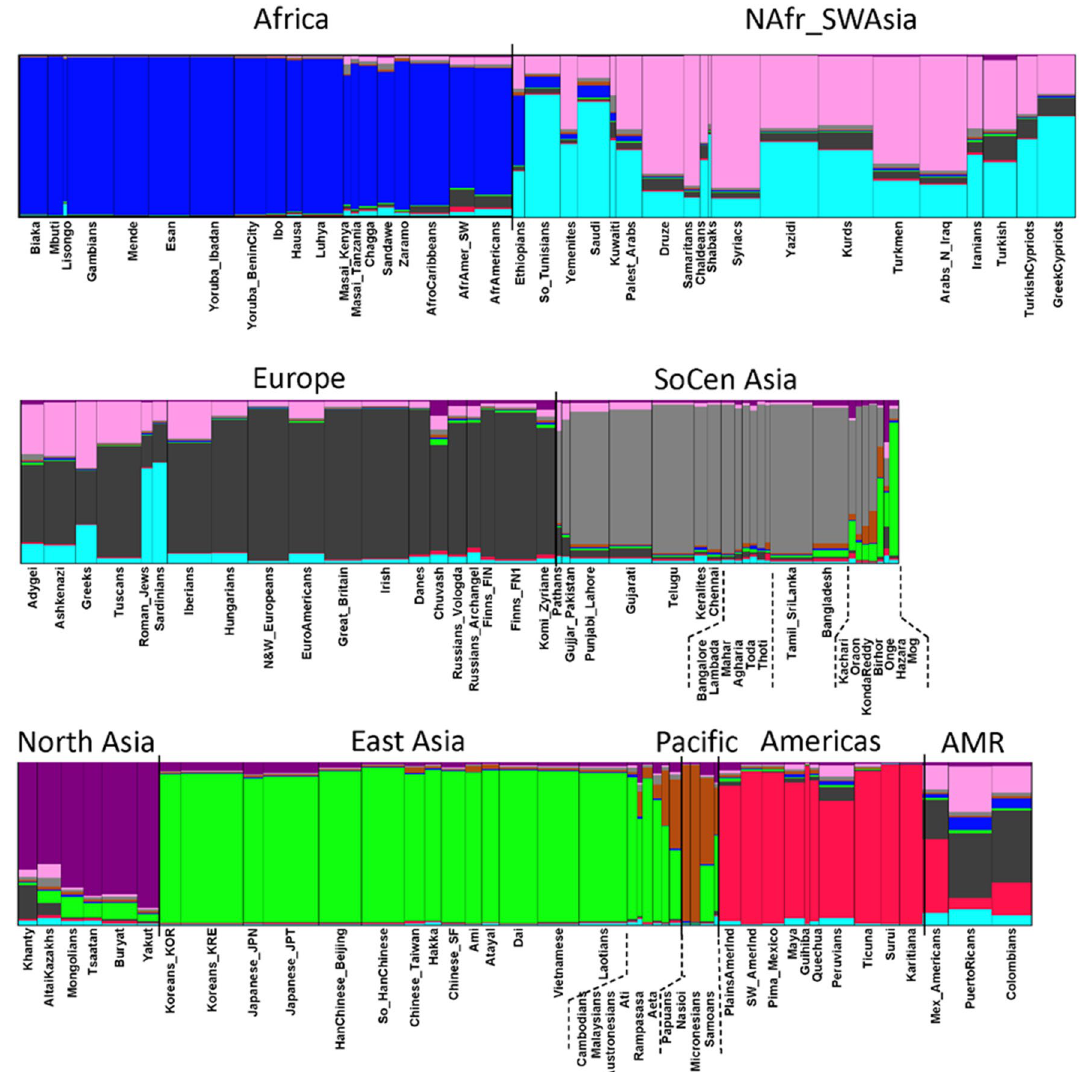
Figure 2. STRU CTU RE results by population averages for 122 populations at K = 9. The result with the highest likelihood is shown as population averages. AMR indicates the American populations from the 1000 Genomes dataset that have very low Native American ancestry and have predominantly European and some West African ancestry. The plots for K = 7 through 9 are shown in Supplemental Fig. S2; plots of likelihoods for K values are in Supplemental Fig.